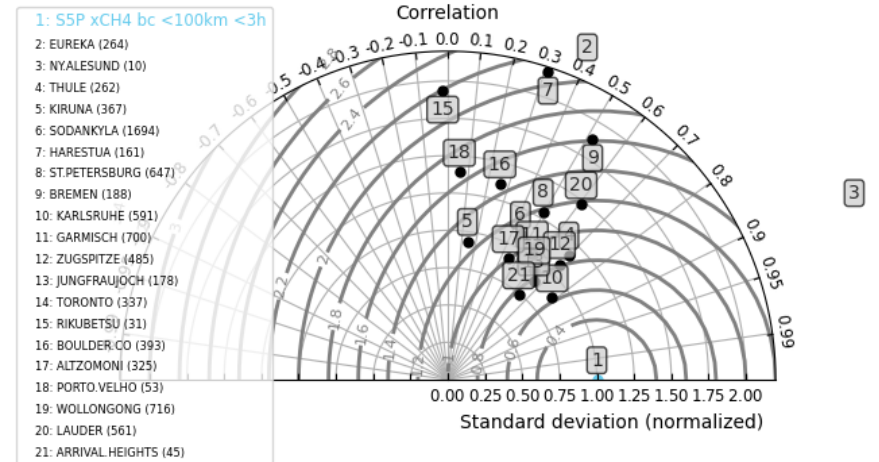
Figure 16. Taylor diagram for daily mean differences between S5P bias-corrected XCH 4 and NDACC XCH 4 data smoothed with S5P a priori and additionally smoothed with the S5P column-averaging kernel at the 20 NDACC stations within the period between November 2017 and September 2020. Spatial co-location with radius of 100km and time of ± 3h around the satellite overpass was used. The stations are sorted with decreasing